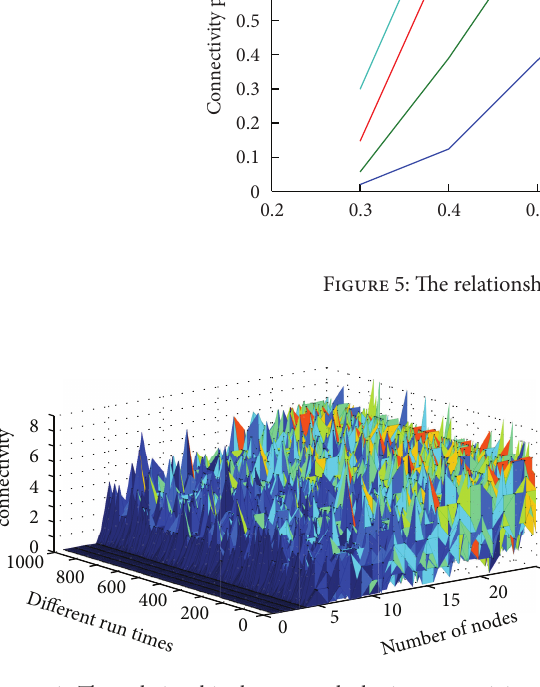
Figure 6: The relationship between algebraic connectivity and connectivity.